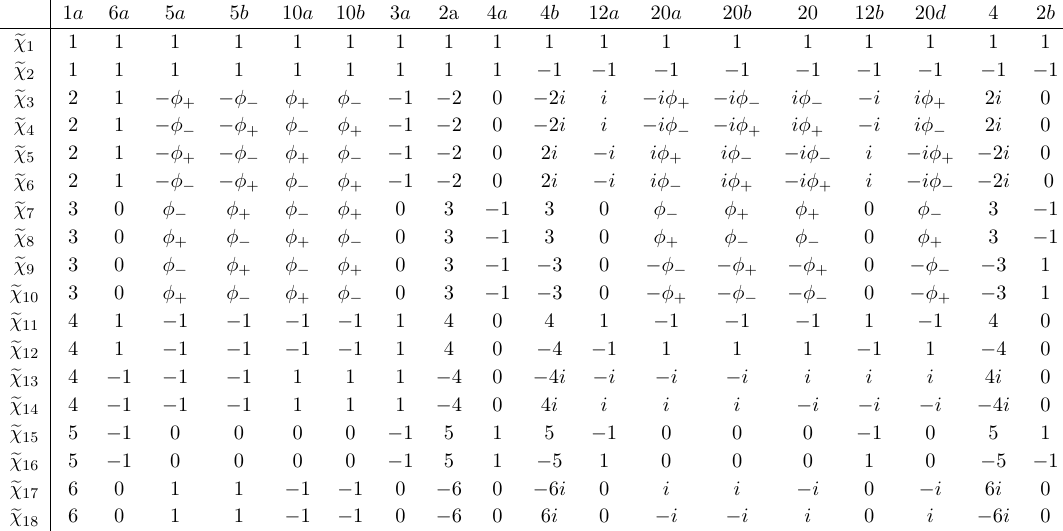
of SL(4 , C ) . We define φ I